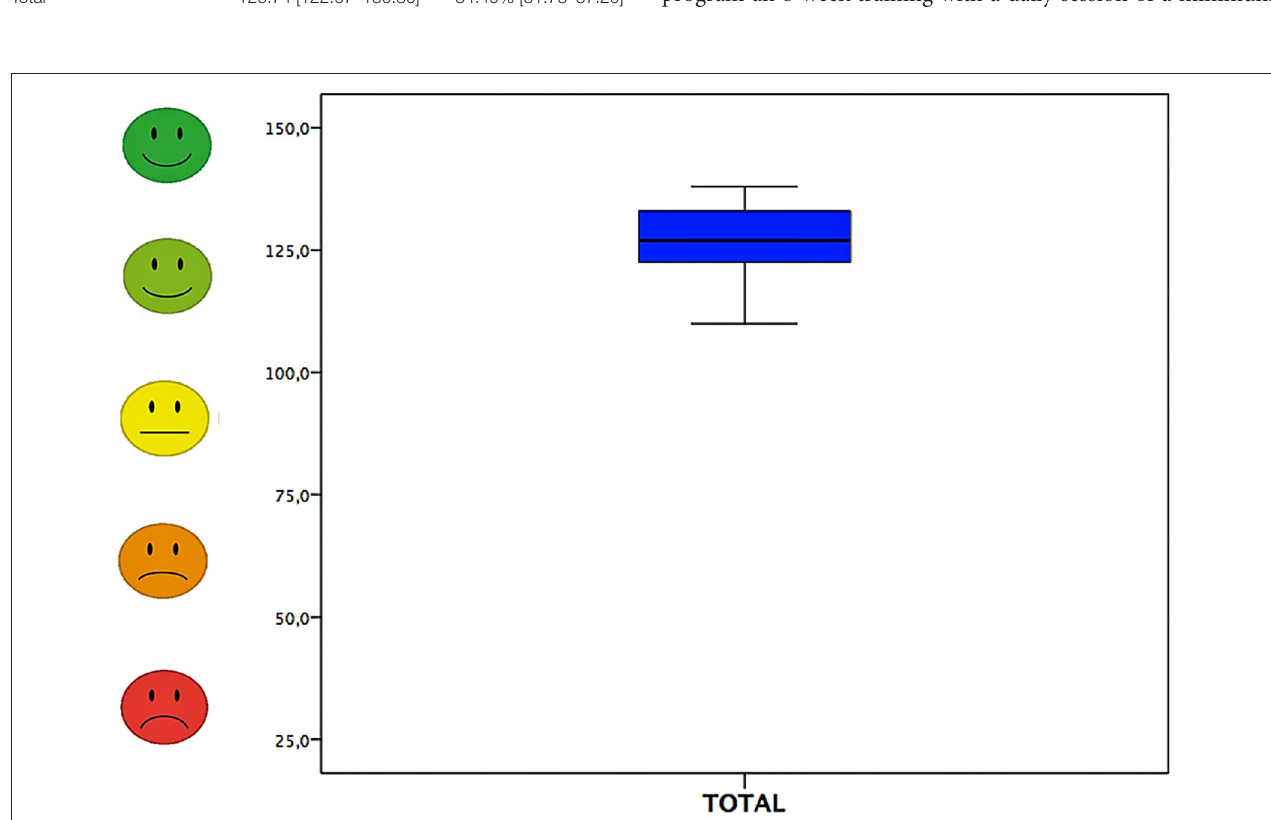
FIGURE 2 | Total answers to the